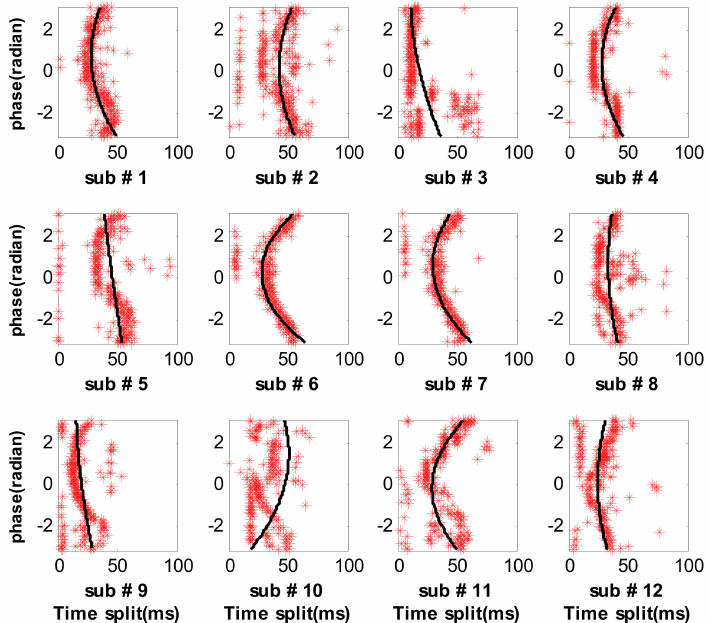
Figure 13. Measured respiratory splits of the 12 subjects by the STFT